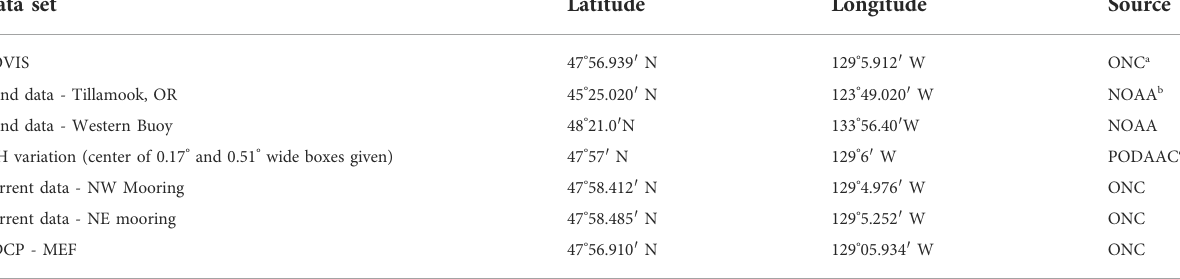
TABLE 1 Data set summary.